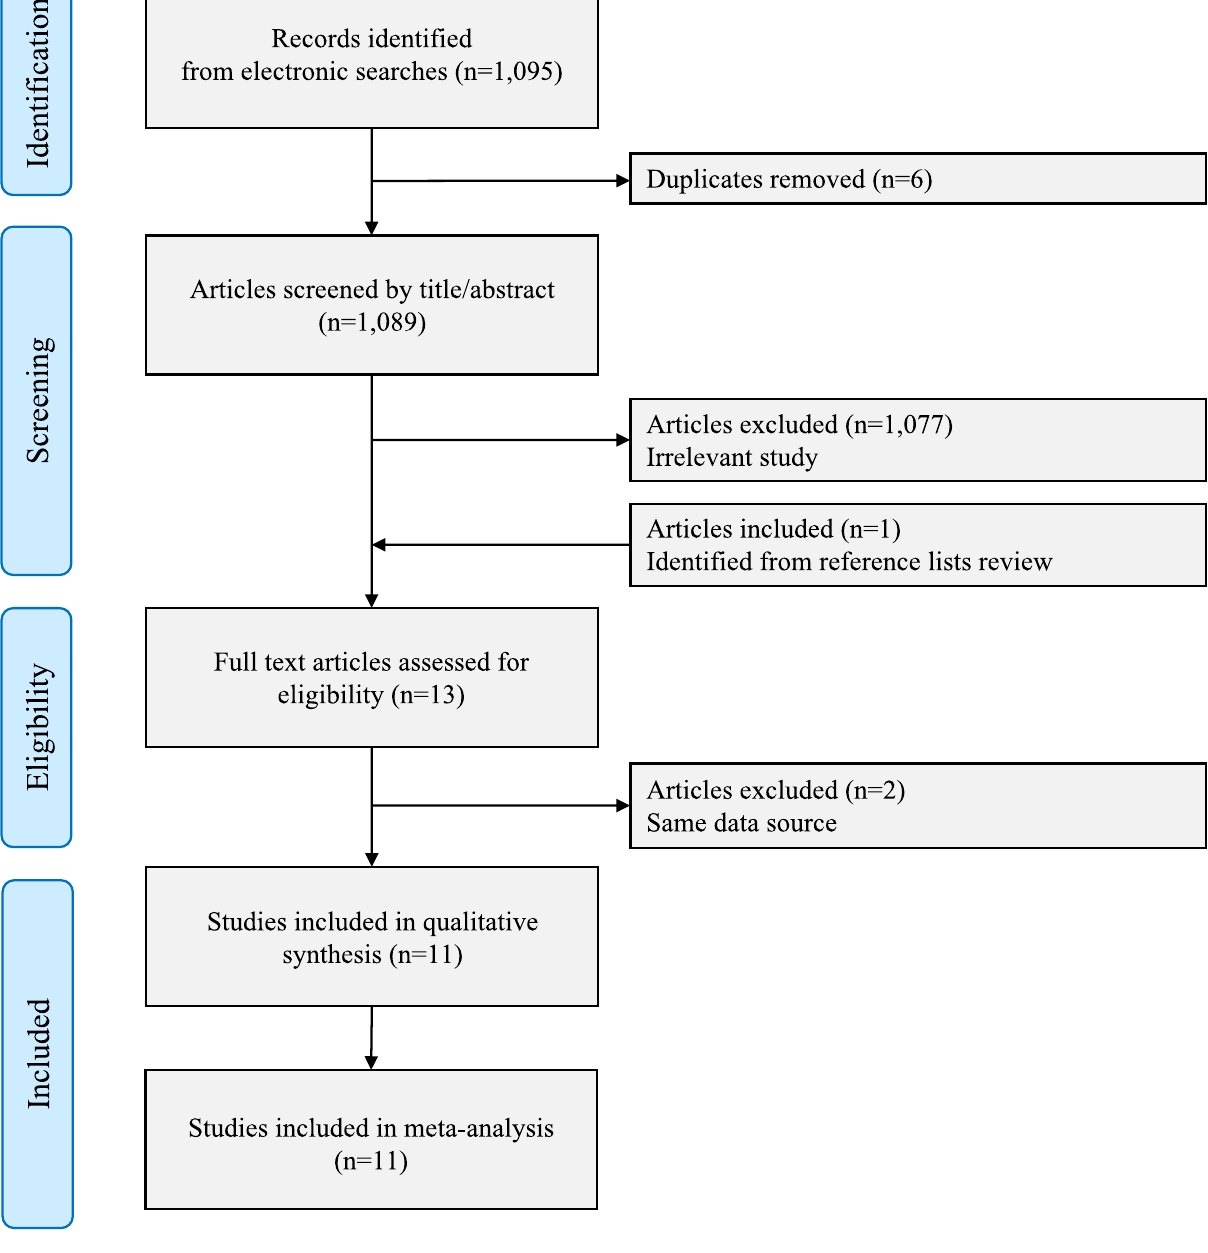
Figure 1. Flow diagram of study selection. n